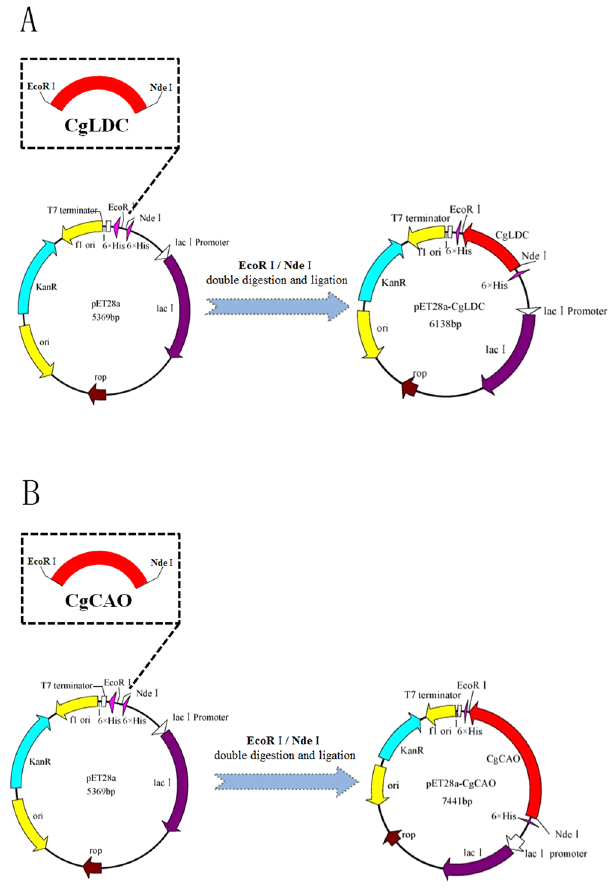
Figure 1. Construction of expression plasmids. ( A ) Construction of the expression plasmid pET28a-CgLDC. ( B ) Construction of the expression plasmid